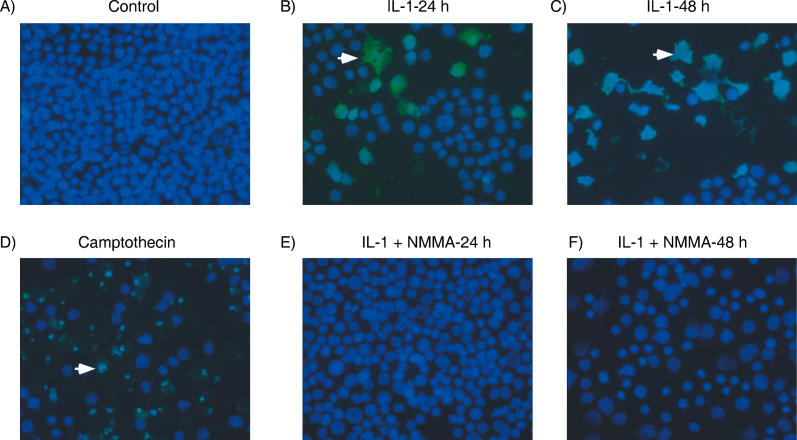
IL-1 Stimulates RINm5F Cell DNA Damage in a Nitric Oxide-Dependent MannerTreatment of RINm5F cells for 24 h (B) or 48 h (C) with IL-1 (10 units/ml) resulted in DNA damage, as determined by TUNEL staining (green fluorescence). DNA damage was attenuated by NMMA (E and F). The apoptosis inducer camptothecin (25 μM) stimulated DNA damage (D), and this DNA damage is morphologically distinct from that induced by IL-1. Nuclei are stained with DAPI (blue). The morphological differences in TUNEL staining, the loss of nuclear membrane integrity in response to IL-1 (B and C) and the condensation of DNA in response to camptothecin (D) are highlighted using white arrows. The levels of DNA damage in control cells (A) were less than 5%. Results are representative of three independent experiments.